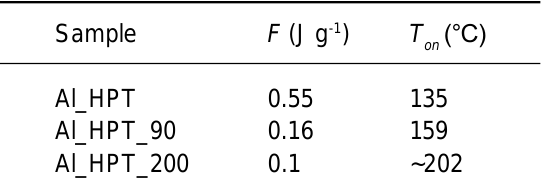
Table 2. Results of DSC studies. F is the amount of released heat, T is the temperature of the onset on of heat